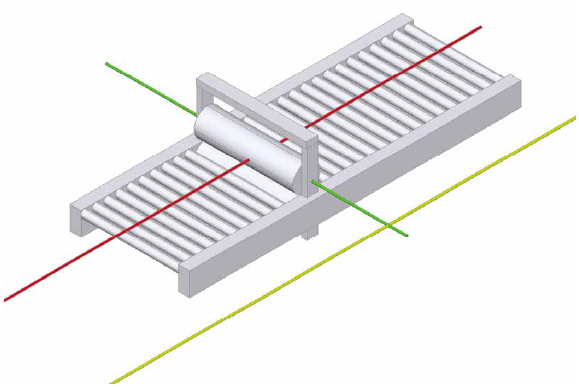
Fig. 4. Axes creation at the rolling